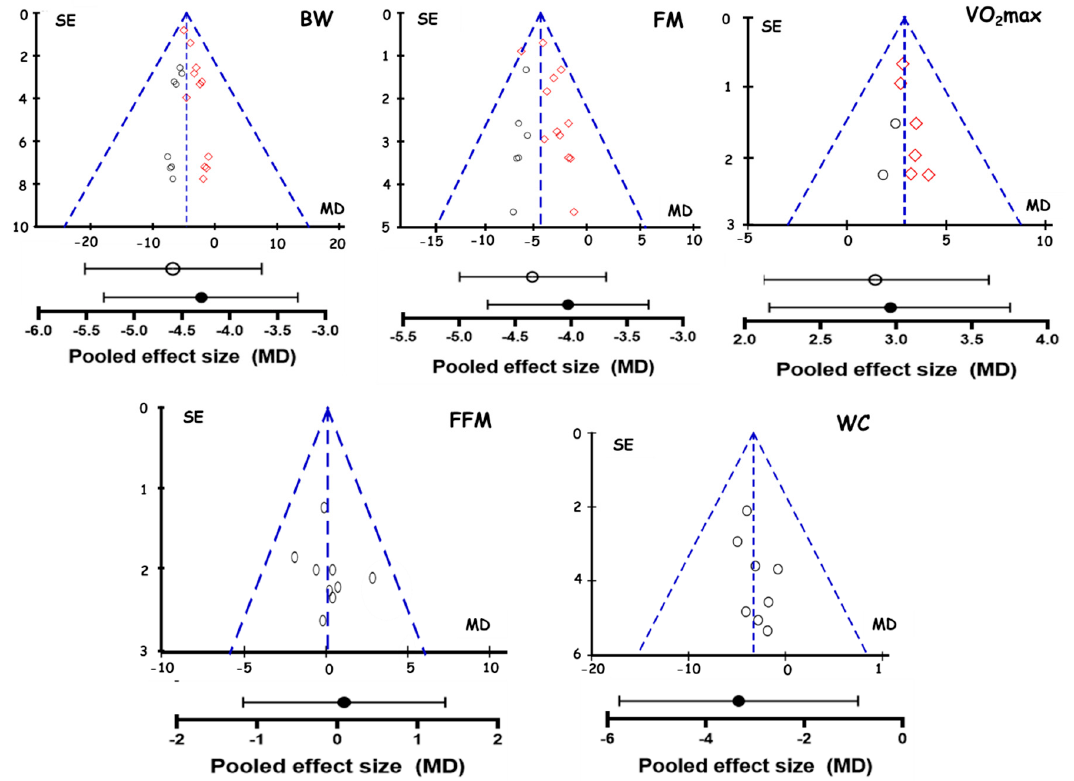
Figure A3. Top panels are the funnel plots for observed mean differences. Rhombus are original data while open circles are imputed filled values in BW, FM, and VO 2 max graphics. For FFM and WC, only original data is shown due to normal data distribution. Bottom panels show the pooled effect sizes and 90% CI of mean differences before (solid circles) and after being adjusted for publication bias (open circles).